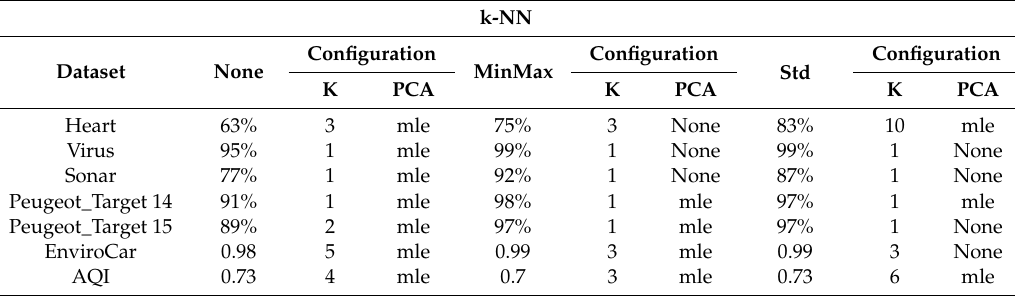
Table 18. Performance and configuration of k-NN for di ff erent scaling techniques.